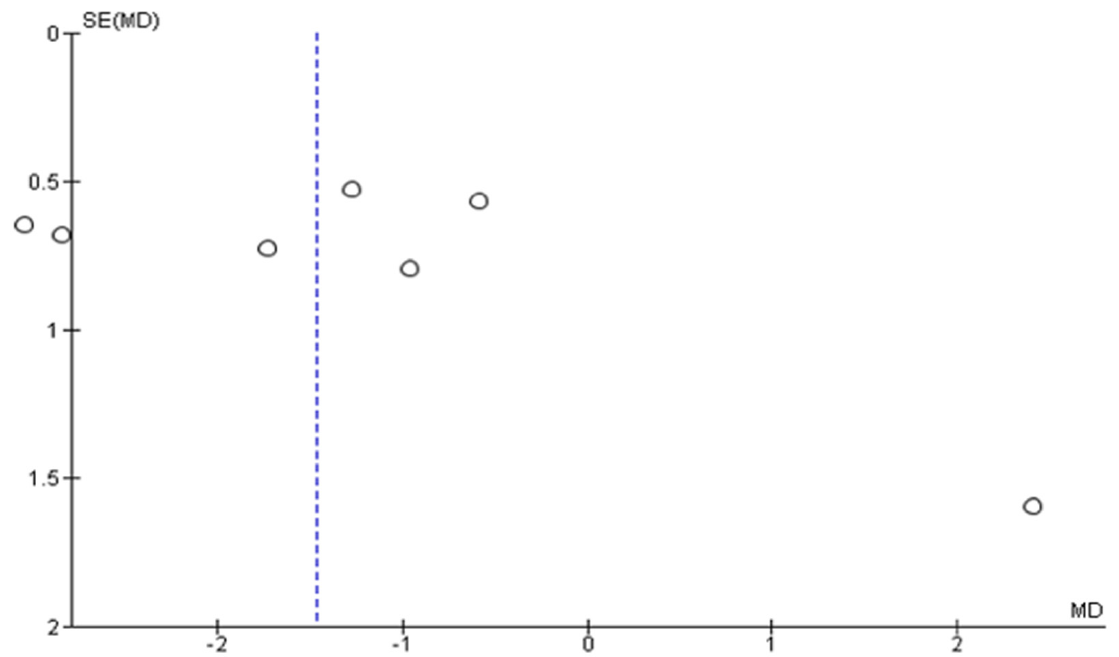
Figure 7. Funnel plot summary for primary outcome qualitative pain/burning sensation reduction assessment (VAS) from baseline up to the final follow-up timepoint.